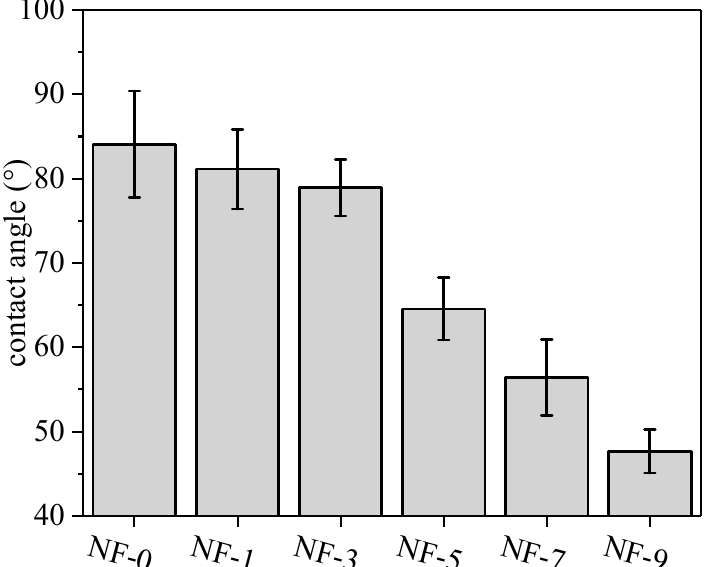
Figure 7. Contact angle of NF membranes with different DWCNT dosages.